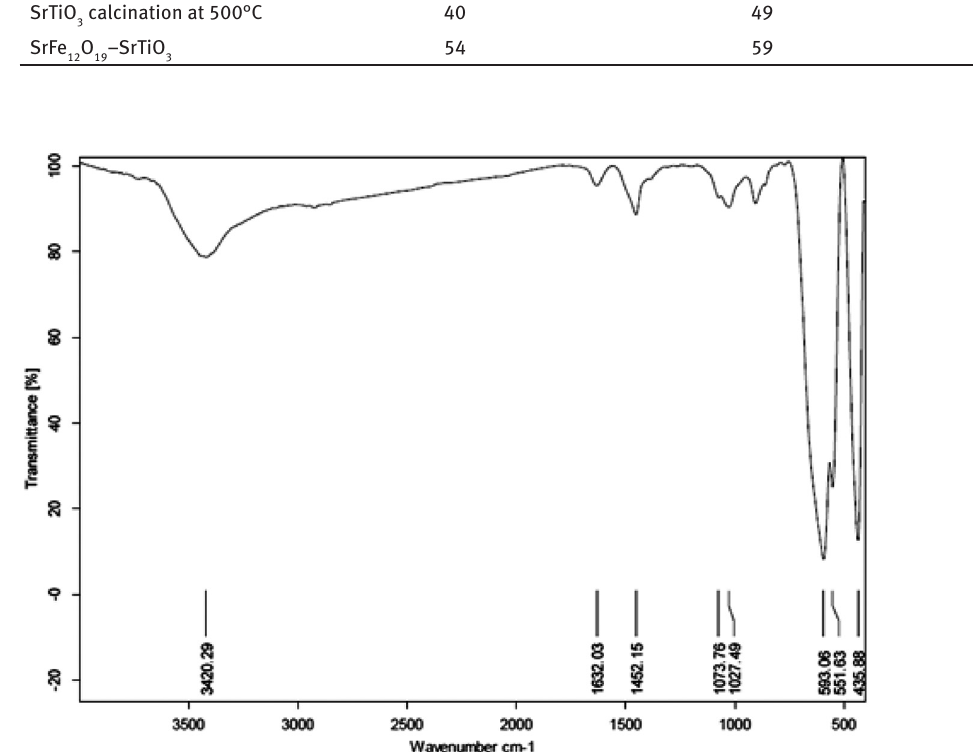
O calcinated at 12 19